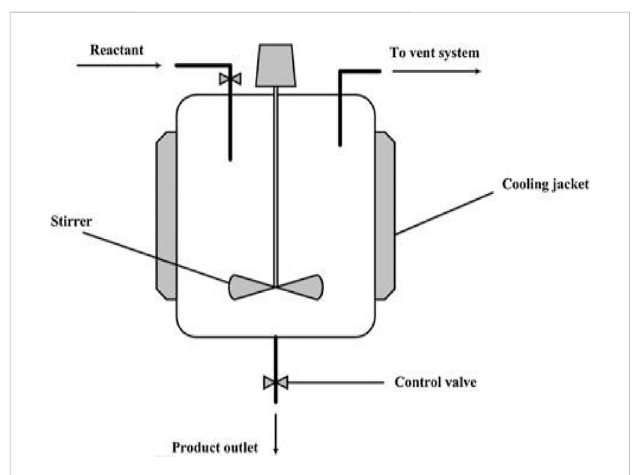
FIGURE 12 Batchreactor(sequential)withstirrer (The University ofYork,